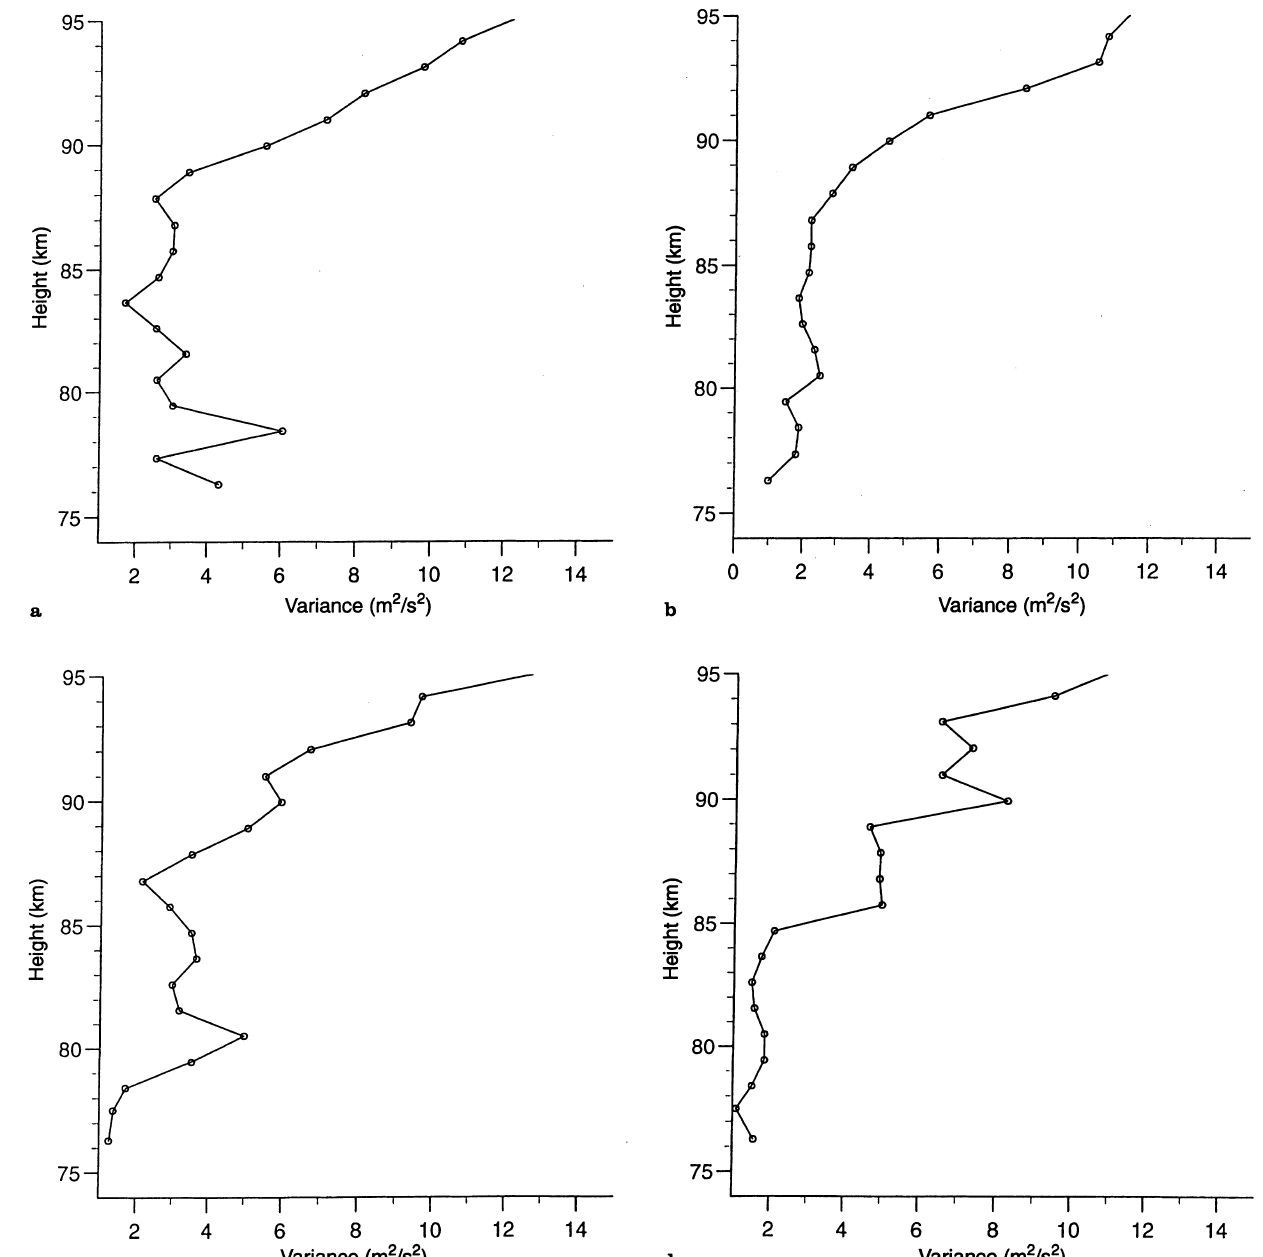
Fig. 5 a–d. Profiles of the daily-mean variance of vertical velocity for four successive days in 1991. a 17 March, b 18 March, c 19 March and d